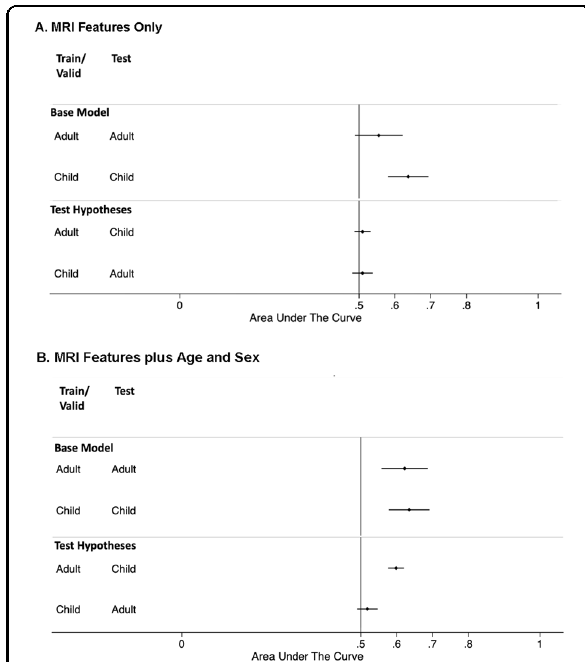
Fig. 1 Area under the receiver operating characteristic curve for the test results. Area under the receiver operating characteristic curve (AUC) accuracy statistics for the held-out test results were plotted (as dots) with their 95% con fi dence intervals (as horizontal lines). The vertical line at an AUC of 0.5 indicates a chance level of diagnostic accuracy. If the 95%CI does not overlap with the 0.5 vertical line, it indicates signi fi cant predictive accuracy. A AUC comparison of the models using only MRI features. A AUC comparison of the models using MRI features plus age and sex. In both A and B , the Top portion shows the base models, where models were trained and validated in child or adult samples and tested on their corresponding age groups; Bottom portion tests the hypotheses that if model trained/validated on child samples can also predict adult ADHD and vice versa. Note that test sample consists of combined training, validation, and test sets from the other age group because they are not used in the model optimization and